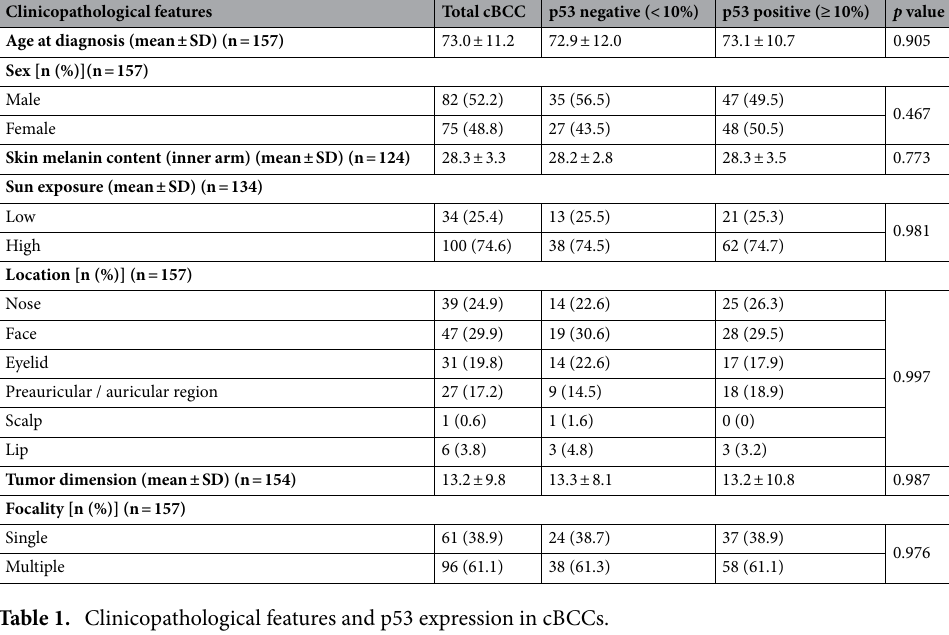
Histopathological